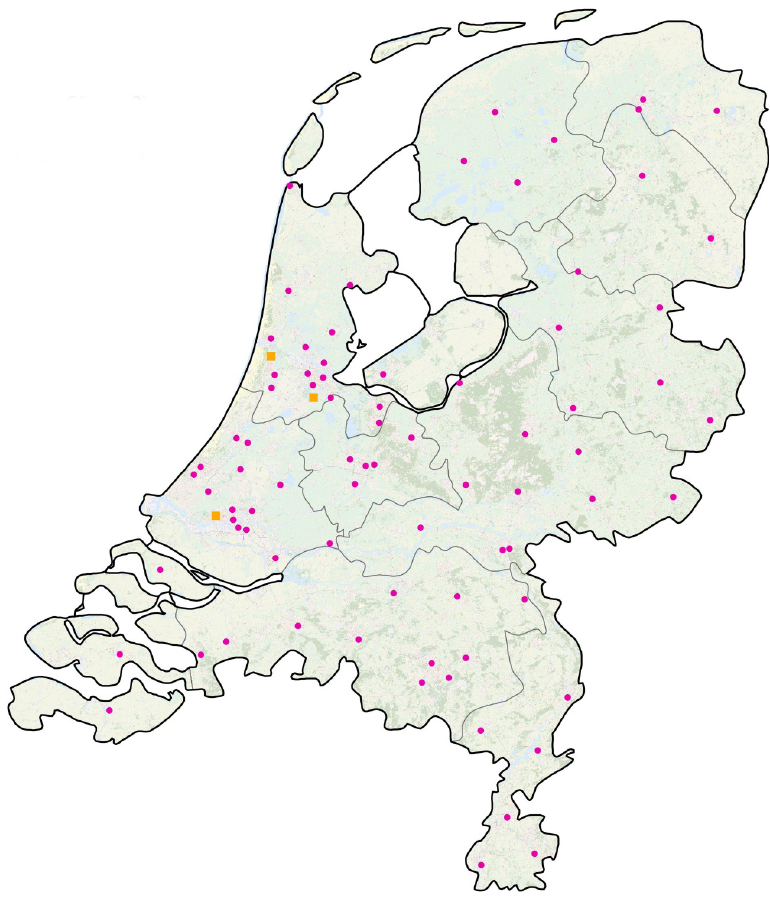
Fig 1. Emergency departments in the Netherlands (June 2020) [15]. Pink circle: Opened 24 hours, 7 days a week. Yellow square: Opened day and evening, 7 days a week.